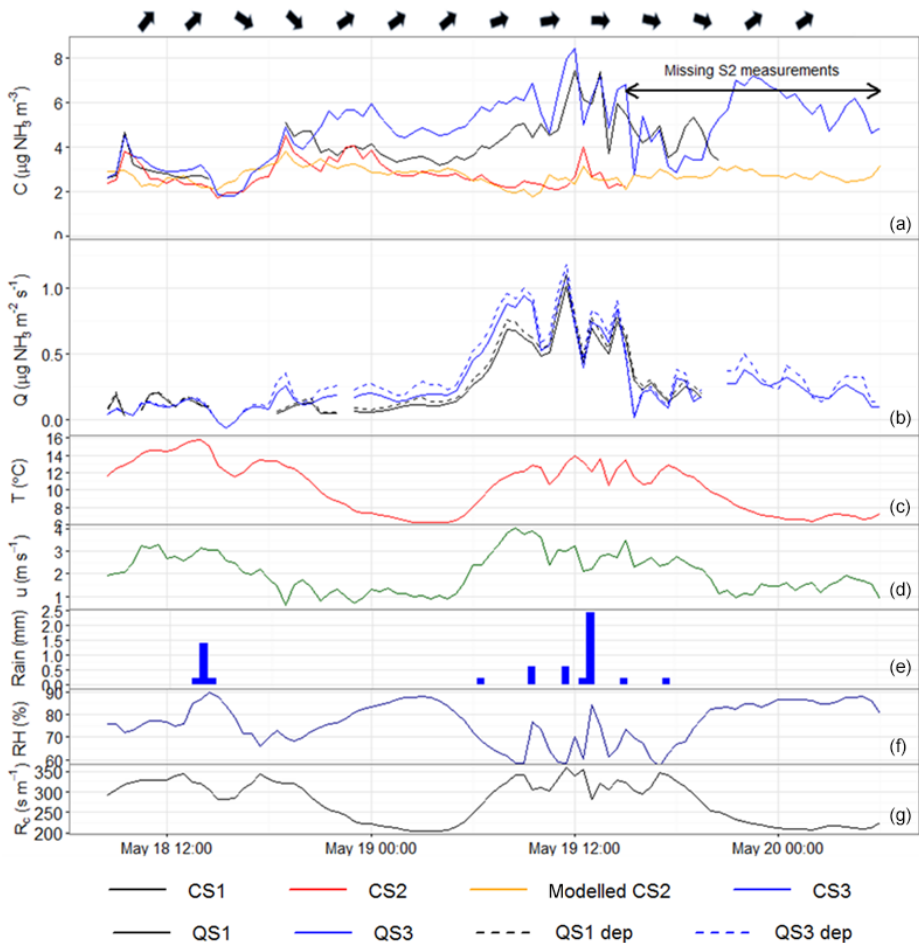
Figure 4. Time series of Period 1 DOAS concentration measurements (CS1, CS2, CS3 and modelled CS2 using Eq. 5, a ) and bLS-R emission estimates ( Q and Q dep scenarios, second panel), with T , u , rain, RH, and modelled R c using Eq. (4) shown in the panels below. Wind direction arrows are set above the top panel to visualise changes over time. The cattle were present on the field for the full time period shown (08:00 18 May–15:00 20